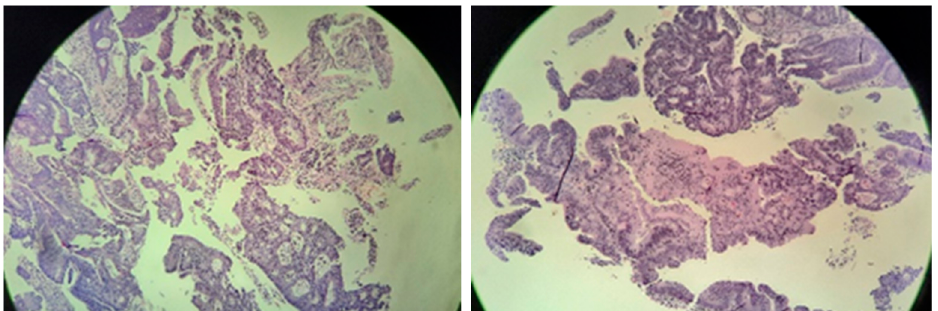
Figure 4. Microscopic images of cecal adenocarcinoma.